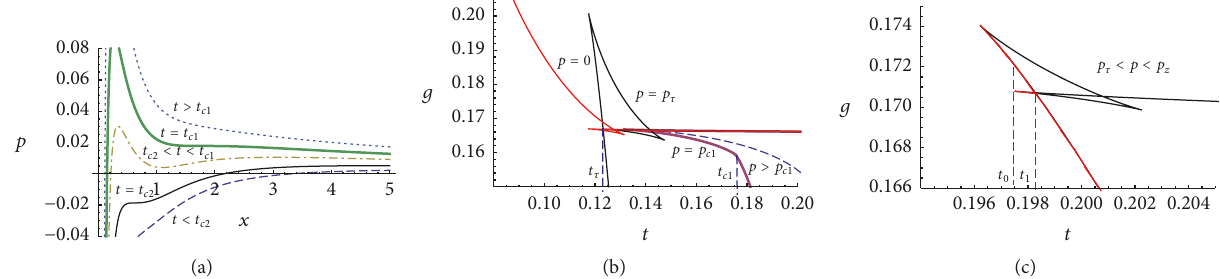
Figure 2: Born-Infeld AdS black holes for 𝑑 = 4 and 𝑤 2 = −0.124 . (a) The 𝑝 − 𝑥 diagram shows the existence of two critical points, one at positive pressure 𝑝 𝑐1 ≈ 0.0177545 , the other at negative pressure 𝑝 𝑐2 ≈ −0.0084877 . (b) The Gibbs free energy shows one physical (with positive pressure) critical point and the corresponding first-order SBH/LBH phase transition, occurring for 𝑡 ∈ (𝑡 𝜏 ,𝑡 𝑐1 ) and 𝑝 ∈ (𝑝 𝜏 , 𝑝 𝑐1 ) . (c) There is a reentrant phase transition (RPT) corresponding to the zeroth-order phase transition at 𝑡 = 𝑡 0 followed by a first-order VdW-like SBH/LBH phase transition at the intersection 𝑡 = 𝑡 1 with the swallowtail